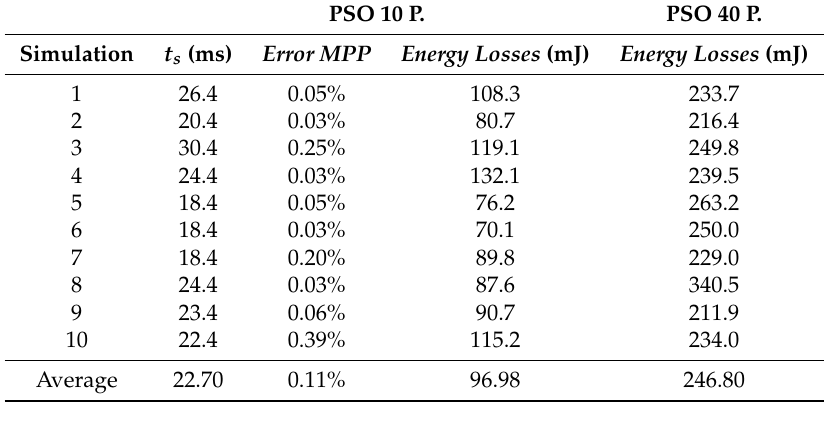
Figure 8. MPPT based in PSO with 10 particles. Profile of the PV panel voltage and power extraction. Table 3. Performance MPPT algorithm based in PSO with 10 and 40 particles. PSO 10 P.